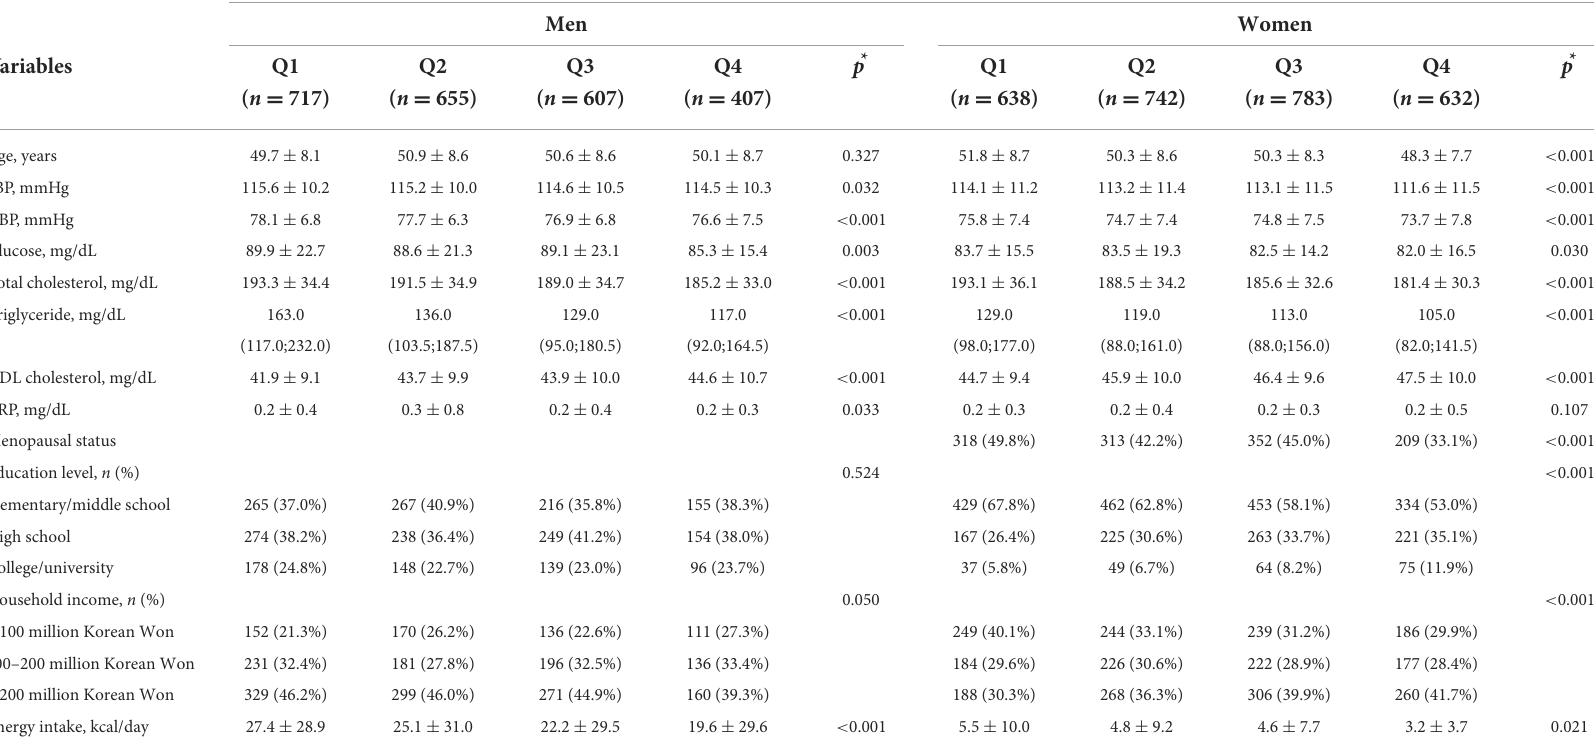
TABLE 2 Baseline characteristics of the study